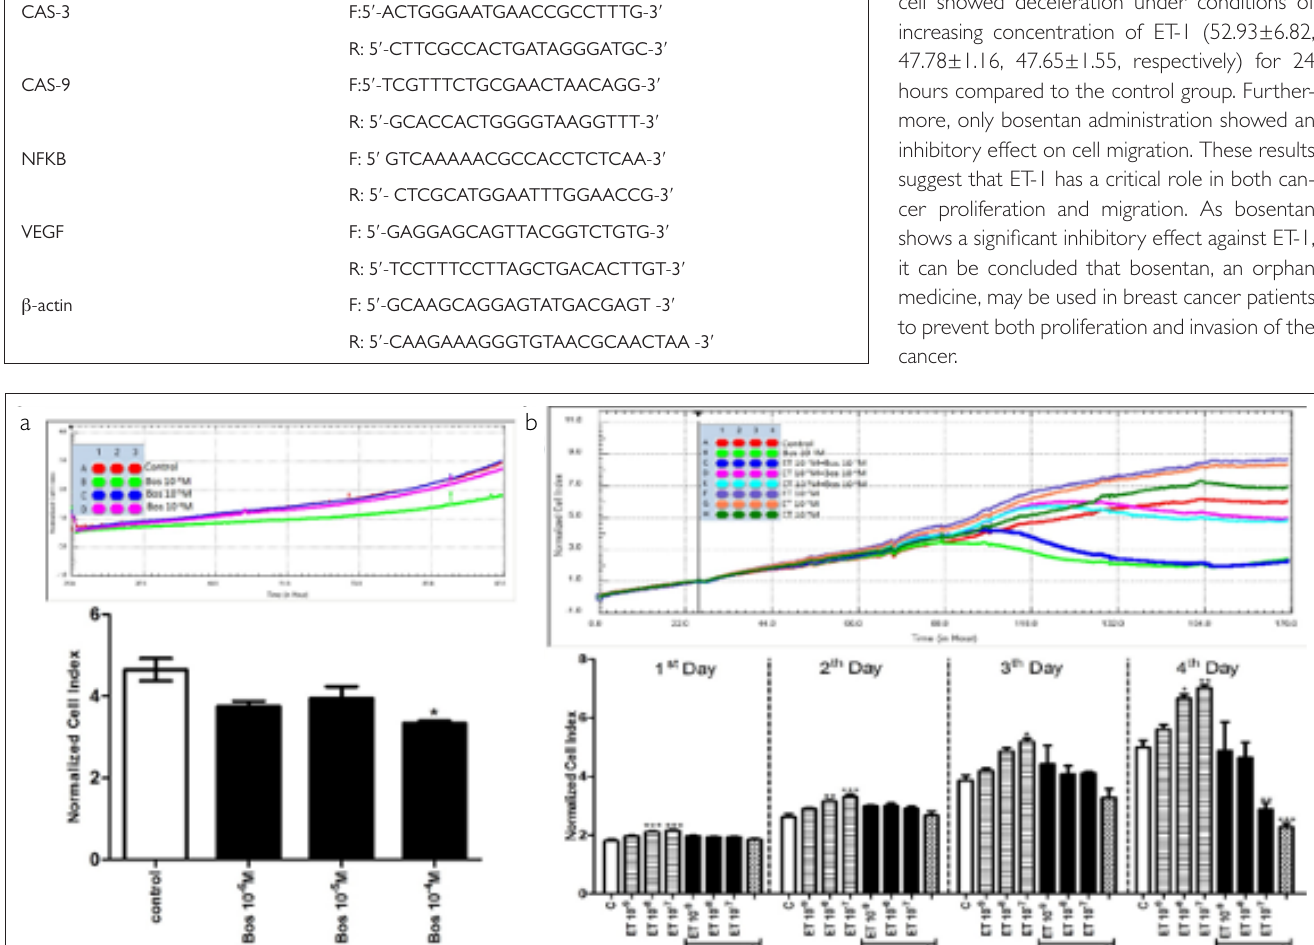
Figure 1. a, b. (a) Effects of bosentan on MCF-7 cells (dose dependent manner), (b) Effects of ET-1 and bosentan on tumor proliferation. Columns are shown as mean±SD, (*p<0.05, **p<0.01, ***p<0.001)